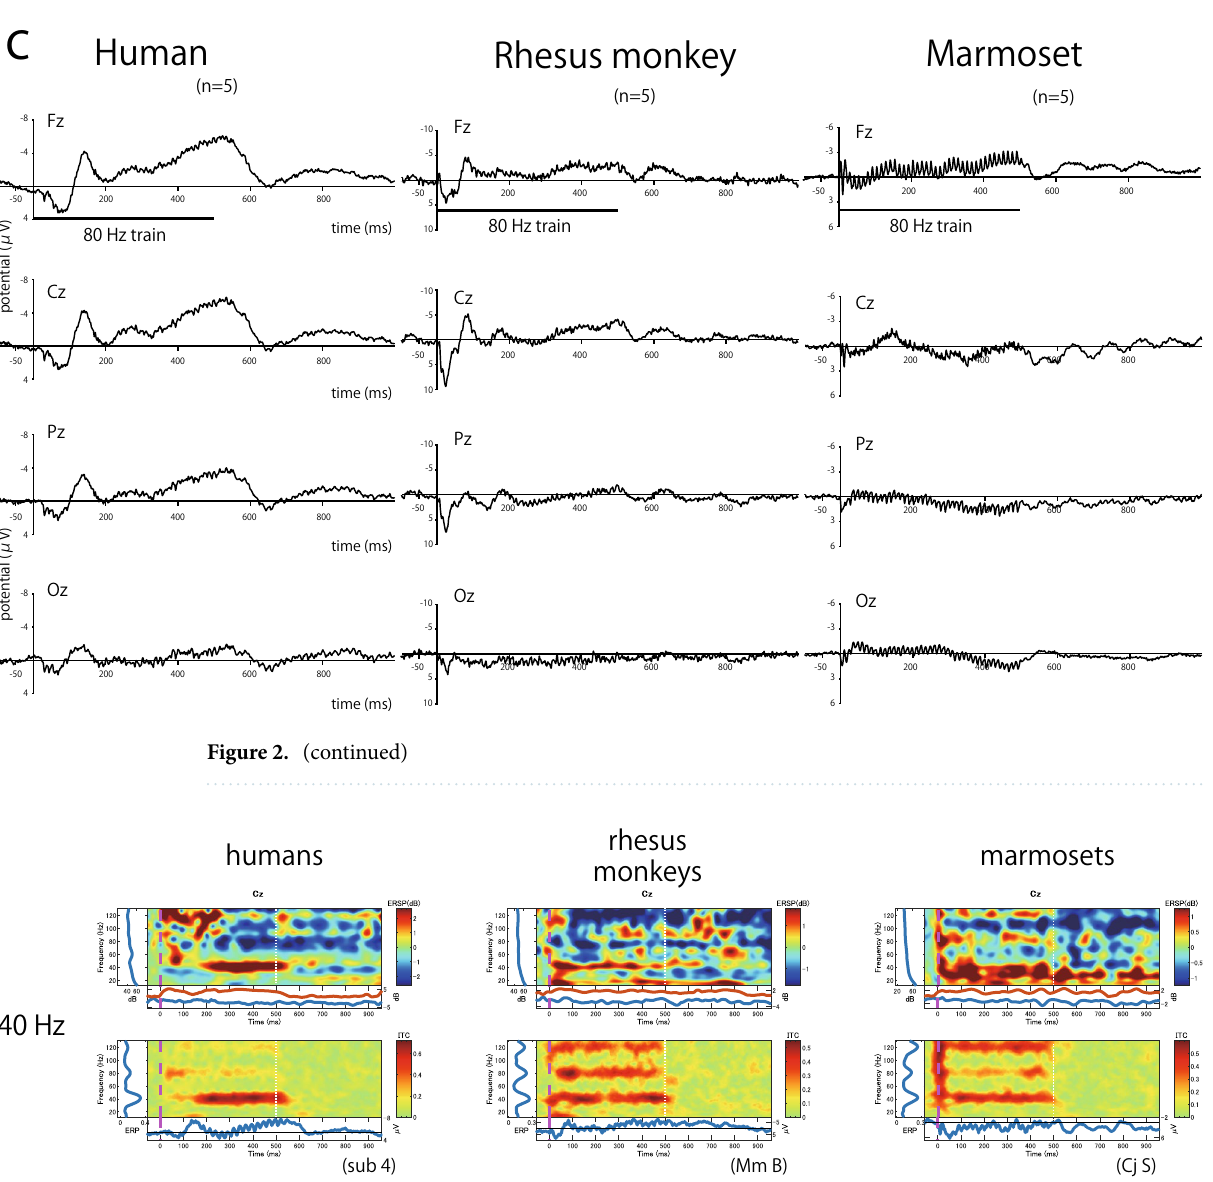
Figure 3. Time–frequency analysis. Example of time–frequency plots of event-related spectral perturbation (ERSP) (upper row in each species) and inter-trial coherence (ITC) (lower row in each species) for the 40 Hz stimulus frequency in humans, rhesus monkeys, and common marmosets. The data was recorded from the Cz electrode. The vertical line of time 0 indicates the beginning of the stimulus, and the vertical white line (on time 500 ms) indicates the end of the stimulus. Horizontal bands were obvious in 40 Hz in both ERSP and ITC maps. In addition to the 40 Hz band, synchronized activity in 80 Hz was also observed as a harmonic